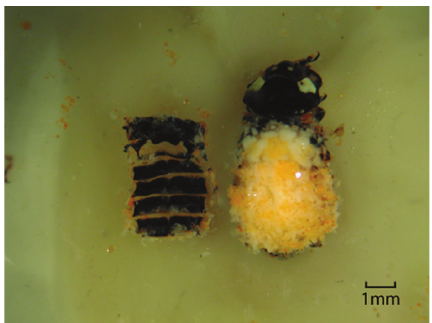
Figure 1: Photomicrograph of “stage 1” dissection of C. septem- punctata with elytra and tergites removed which enabled in situ visualization of the dorsal aspect of gross internal anatomy.